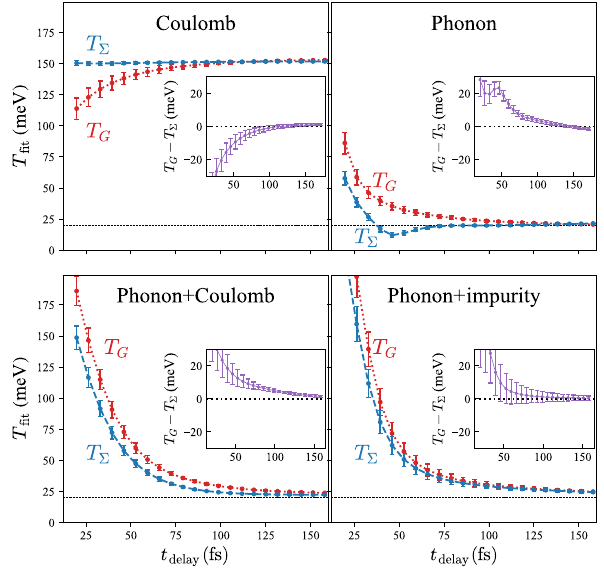
FIG. 10. Effective temperatures extracted from fits to Fermi- Dirac functions for the Green ’ s function (populations) and self- energy. The horizontal line indicates the equilibrium temperature before the pump. The insets show the difference between the population and interaction effective